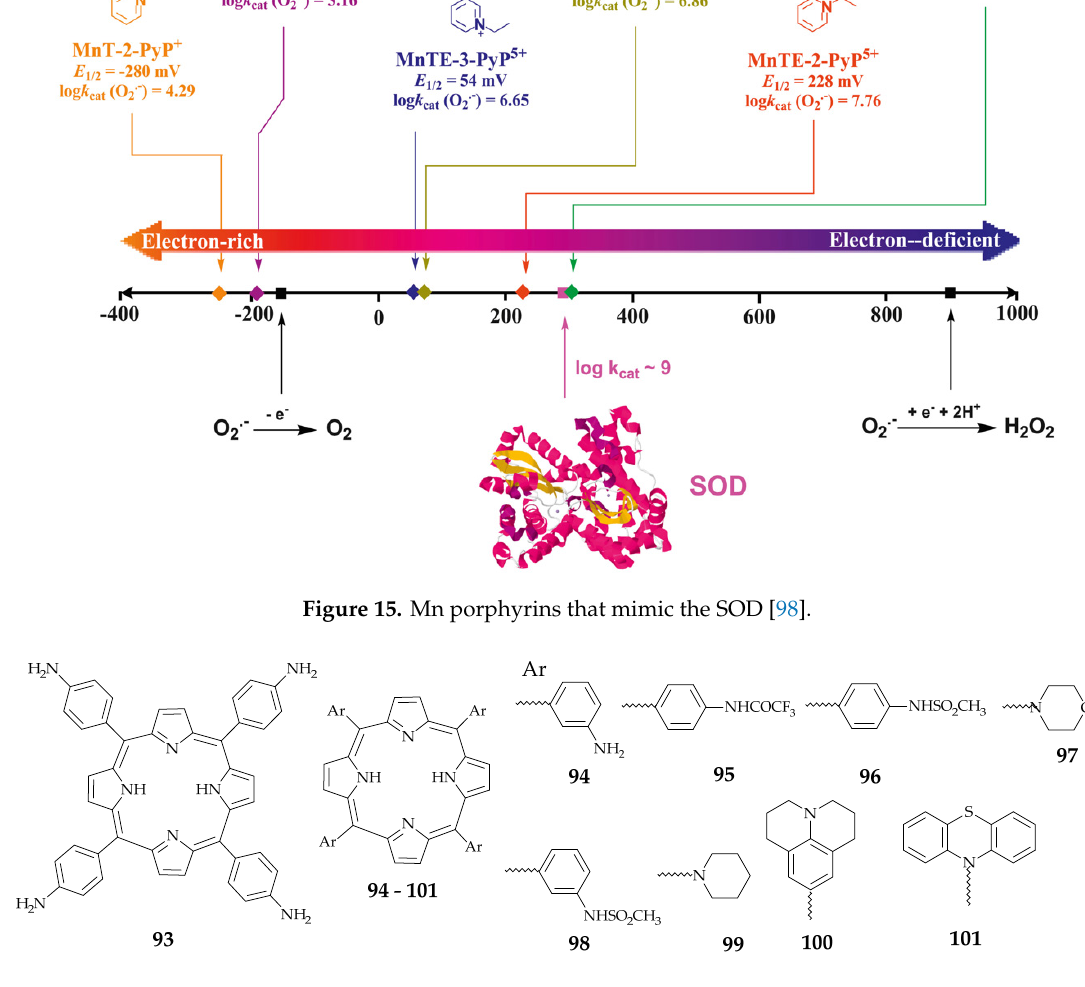
Figure 16. Structures of porphyrin derivatives 93 – 101 .